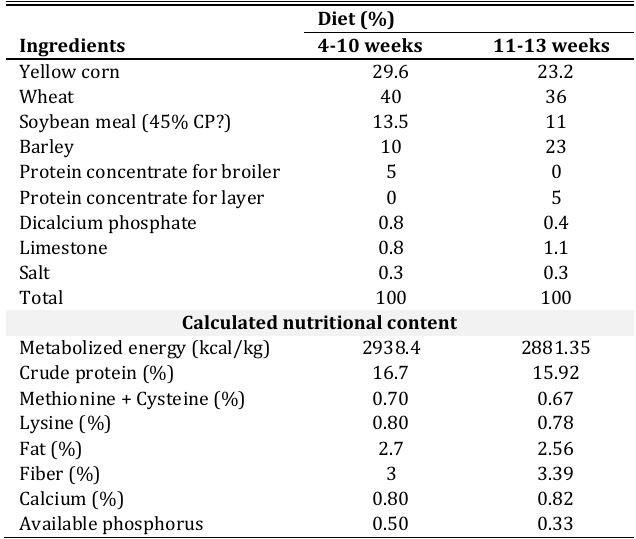
Table 1. Composition of grower diet according to